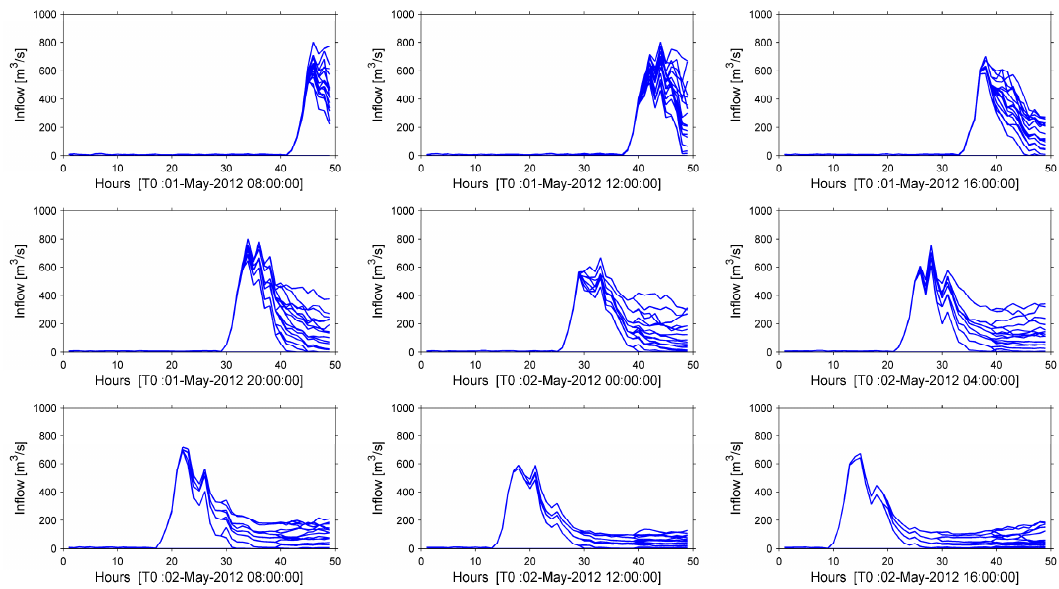
Figure 6. PSF ensemble members (50 members) transformed into optimization trees (16 branches).